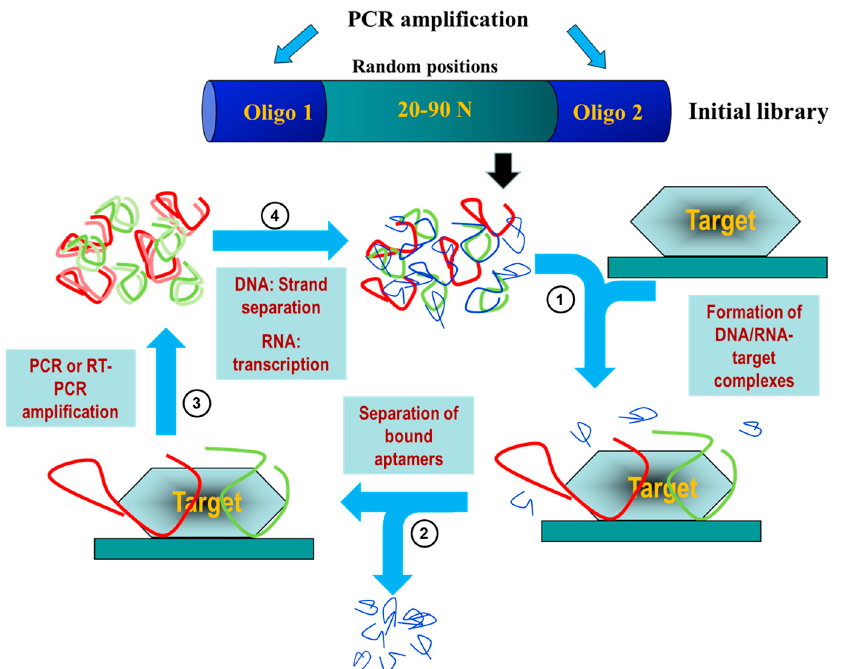
Figure 1. Scheme showing characteristics of each aptamer molecule in the population and the basic steps of a SELEX process. Each aptamer contains a central region with random sequence flanked by constant 5 ′ and 3 ′ ends that serve as primers. The SELEX method consists in iterative cycles of in vitro selection with several critical steps: ( 1 ) incubation with the target; ( 2 ) removal of unbound sequences;